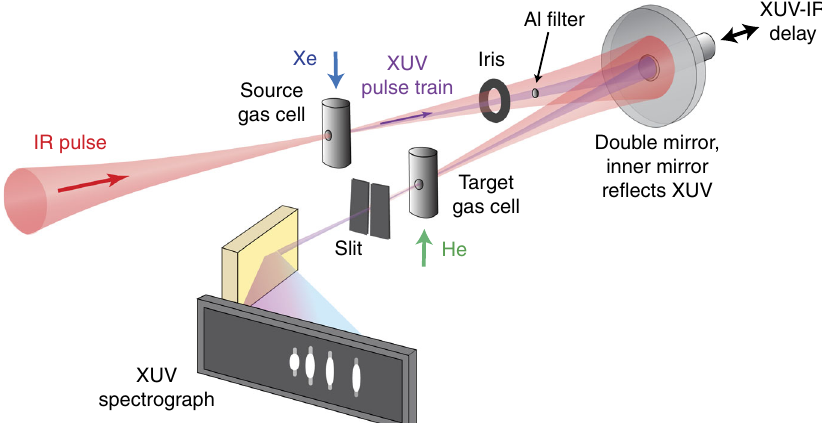
Fig. 5 Experimental setup. The IR beam is focused into the source gas cell where an attosecond pulse train (APT) is generated. The inner part of the IR beam is fi ltered out with a thin Al foil in order to obtain spatially independent pump (APT) and probe (IR) beams. The temporal delay between the beams is controlled by moving the inner segment of the concave focusing mirror. Both beams are refocused into a target gas cell, generating XUV-initiated HHG. The spectrum resulting from the interaction is measured in a grating-based XUV